Question: What kind of plot is shown here?
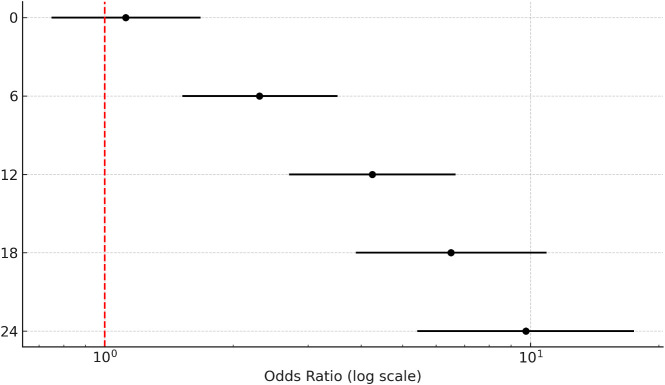
Answer: forest